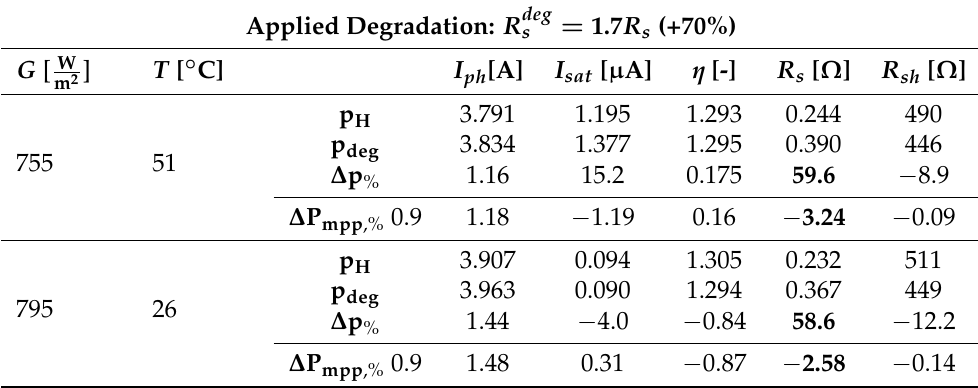
Figure 16. ANN identification of degraded curve with 70% of variation on R s for two different irradiance and temperature conditions. Table 8. SDM parameters estimated with ANN for I - V curves of Figure